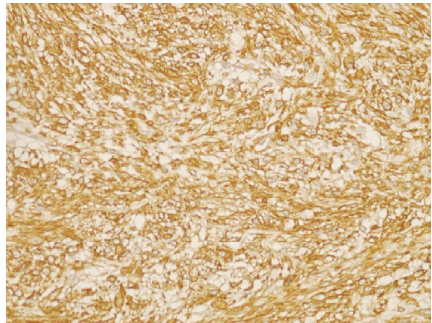
Figure 2: Positive cytoplasmic staining with SMA in nodular fasciitis (SMA ×